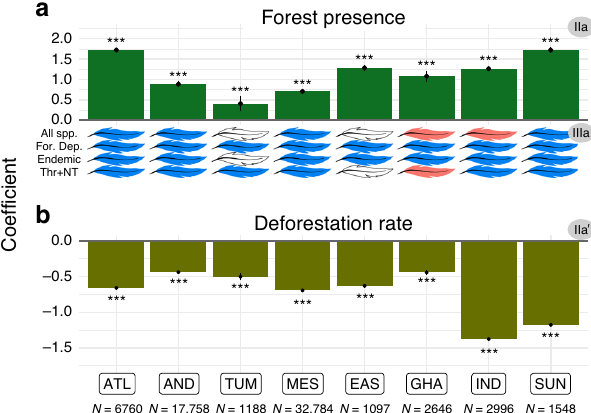
Fig. 4 Effects of protected areas on forest cover, and effects of forest cover on bird diversity, per hotspot. Bars: effects of protected areas on forest presence ( a analysis IIa) or on deforestation rates between 2000 and 2019 ( b analysis IIa ′ ); coef fi cients correspond to the estimates of GAM models; signi fi cance given by P value (***<0.001 < **<0.01 < *<0.05), and 95% con fi dence interval around GAM coef fi cients (vertical error bars). Feathers: colour represents the effect sign (blue: positive; red: negative; white: non-signi fi cant [ P value > 0.05]) of forest presence on each of the bird diversity variables (All spp., overall species richness; For. Dep., richness in forest-dependent species; Endemic, richness in endemic species; Thr + NT, richness in threatened and Near Threatened species). Hotspots: ATL (Atlantic Forest), AND (Tropical Andes), TUM (Tumbes-Chocó-Magdalena), MES (Mesoamerica), EAS (Eastern Afromontane), GHA (Western Ghats and Sri Lanka), IND (Indo-Burma), and SUN (Sundaland). Number of checklists per hotspot is speci fi ed below hotspots names; more detailed results in Supplementary Table 1 and Supplementary Fig.